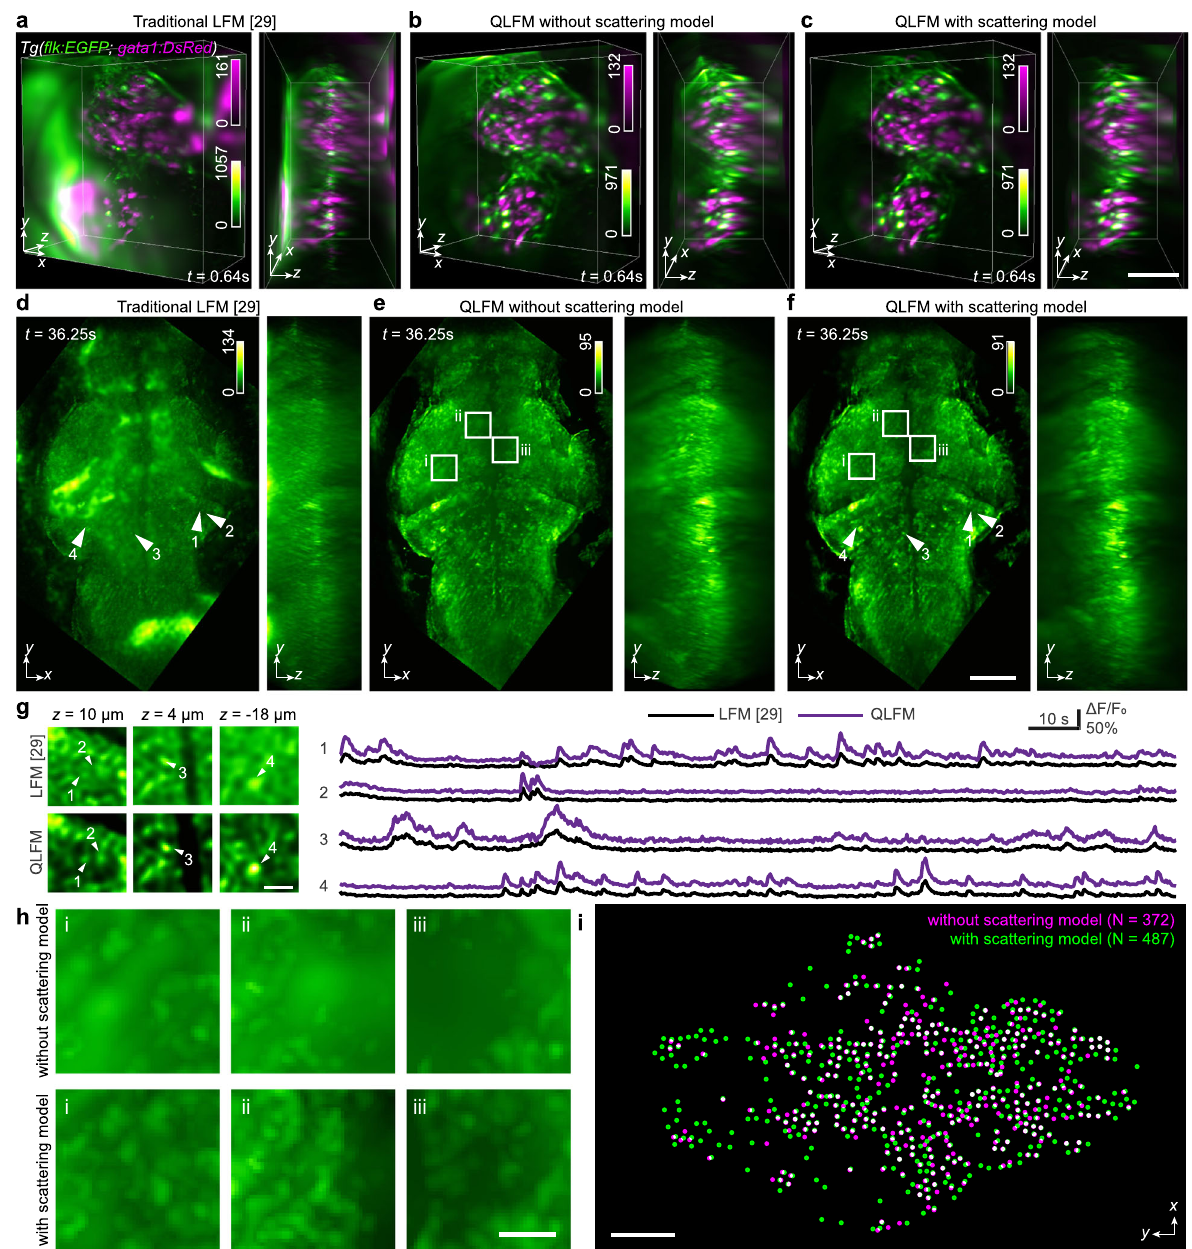
Fig. 4 High-speed volumetric imaging in larval zebra fi sh. a – c 3D rendered volumes of the beating heart at the same time point reconstructed by the traditional LFM, QLFM without the scattering model, and QLFM with the scattering model (Supplementary Movie 2). Successive improvements can be observed with reduced artifacts and background for quantitative imaging. d – f Orthogonal MIPs of the whole brain at the same time point reconstructed by the traditional LFM, QLFM without the scattering model, and QLFM with the scattering model, illustrating the effectiveness of computational optical sectioning in densely labeled samples (Supplementary Movie 3). g Zoom-in regions of the same neurons marked in d and f and their temporal traces for comparison, illustrating the improved SBR. h The white-box regions in e and f are zoomed-in to show that neurons fl ooded by the scattered photons can be resolved with our multiscale scattering model. i Segmentation results (QLFM without the scattering model, magenta; QLFM with the scattering model, green; overlap, white) of 2000 frames reconstructed by different methods, indicating that more neurons can be resolved with the scattering model. Scale bars, 50 μ m ( a – c ), 100 μ m ( d – f ), and 20 μ m ( g , h